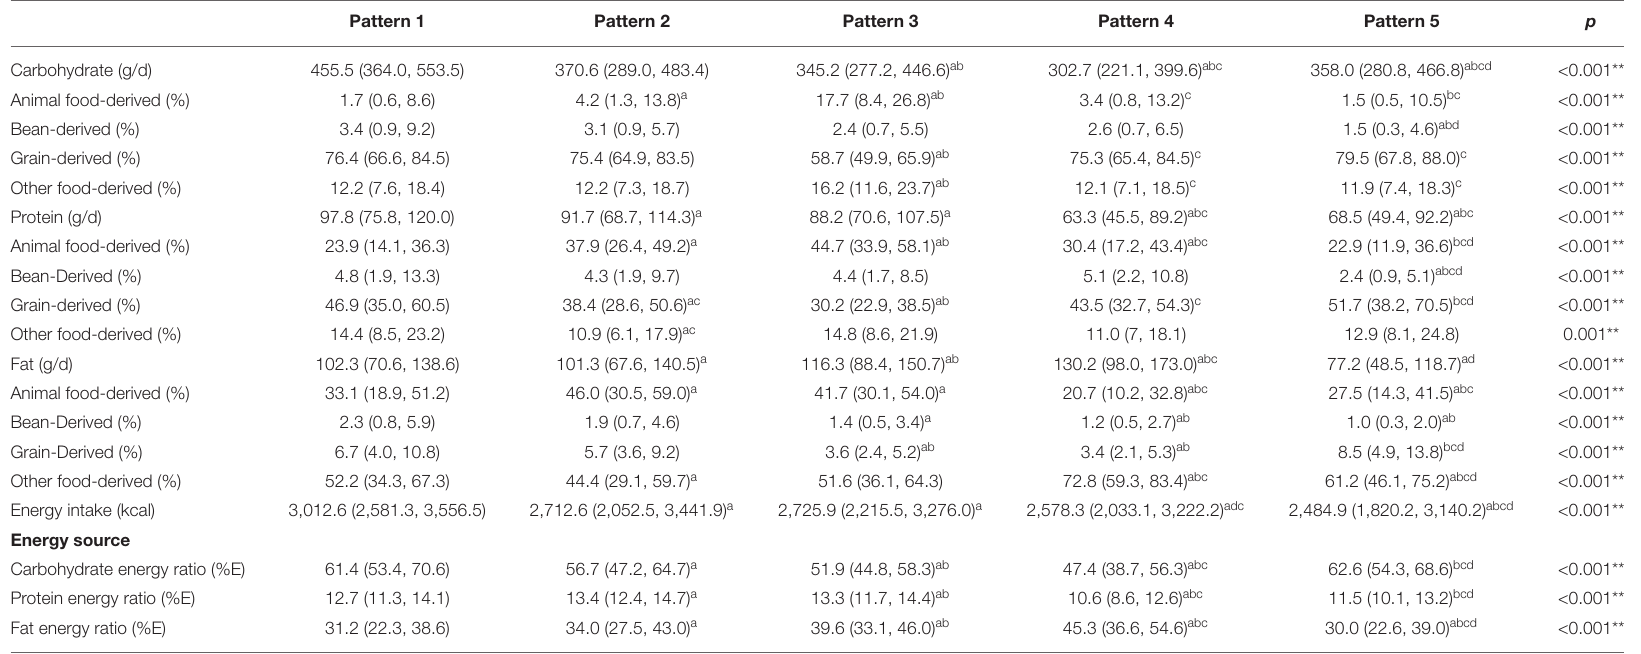
TABLE 4 | Different food-derived and nutrients intake among the highest quartiles of five patterns. Pattern 1 Pattern 2 Pattern 3 Pattern 4 Pattern 5